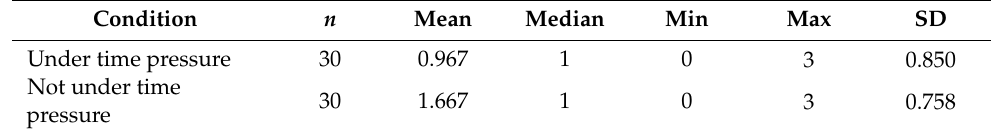
Table 9. Descriptive statistics for renowned brand products purchased.